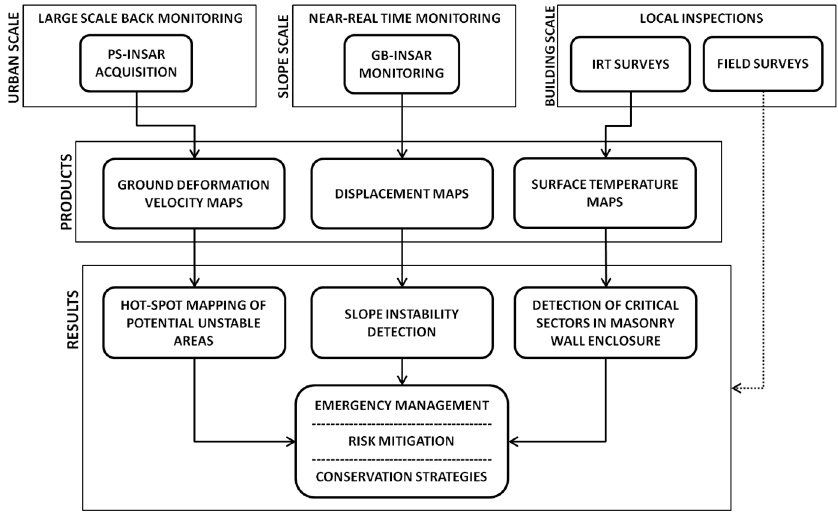
Figure 2. Logic scheme of the applied multiplatform monitoring system.